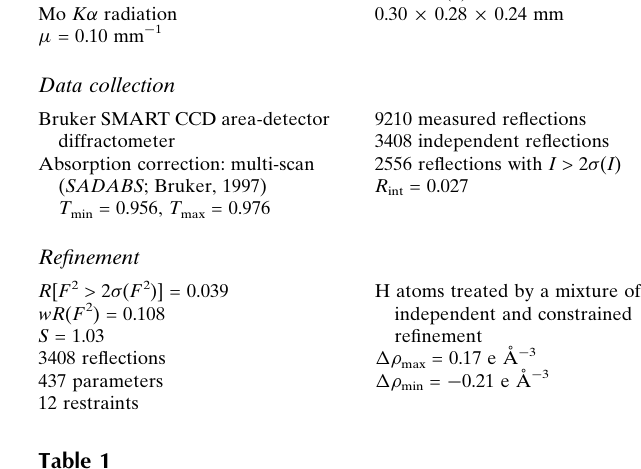
Hydrogen-bond geometry (A˚ , (cid:2)